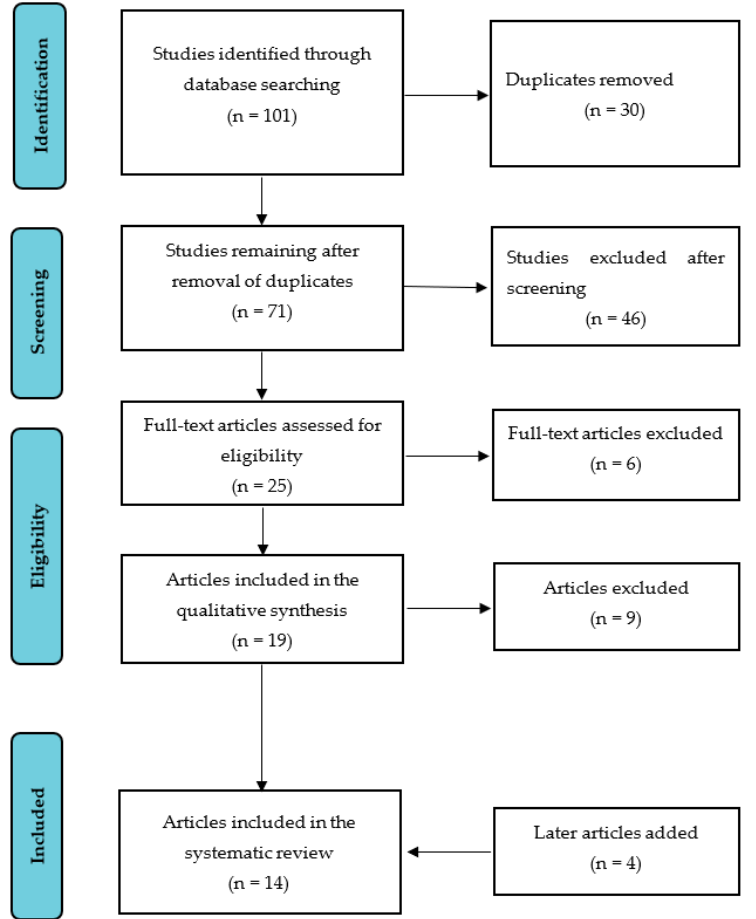
Figure 1. Preferred Reporting Items for Systematic Reviews and Meta Analyses (PRISMA) flow chart of the literature search and selection process.